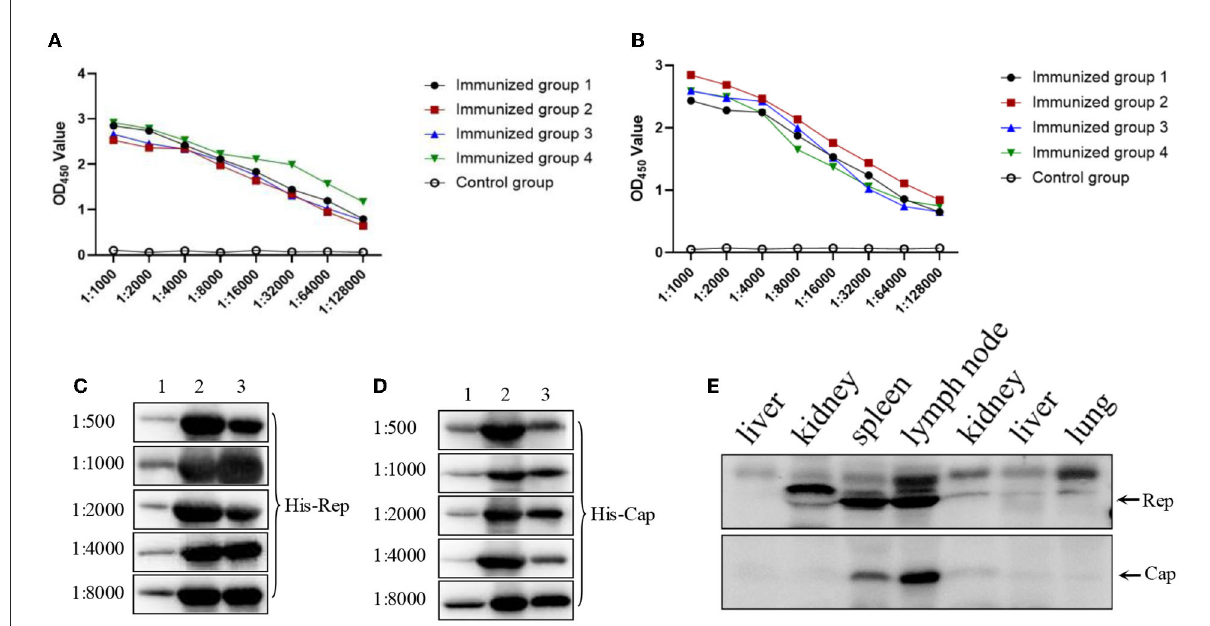
FIGURE2 Immunogenicity examination of both Rep and Cap protein. (A,B) Four mice antibody titers against Rep (A) or Cap (B) after third round immunizations. The data were analyzed using Graphpad Prism software 5.0. OD 450 : optical density 450nm. (C,D) Different antibodies against Rep protein (C) or Cap protein (D) through 1:500 to 1:8,000 were used to react with indicated proteins. The three lanes were as follows: 1, protein expression before induced; 2, protein expression after induced; 3, proteins after purification. (E) Both Rep and Cap antibody (1:1,000) were used to detect the endogenous corresponding protein derived from wild boars’ tissues including liver, kidney, spleen, lymph node, and lung.